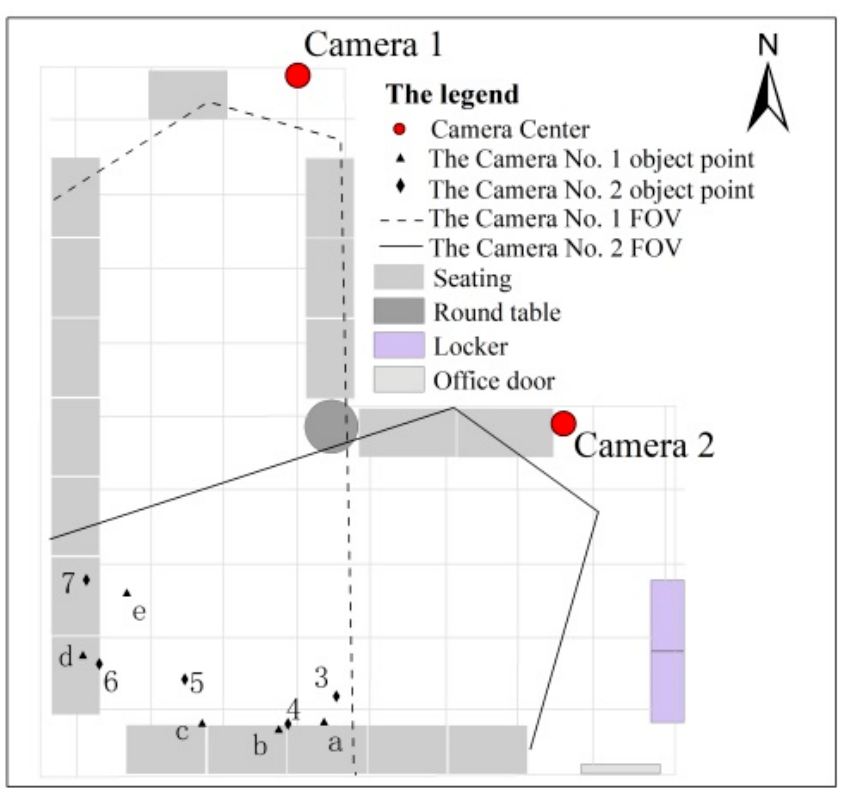
Figure 13. The objects’ distribution in the overlapping FOV of the office.